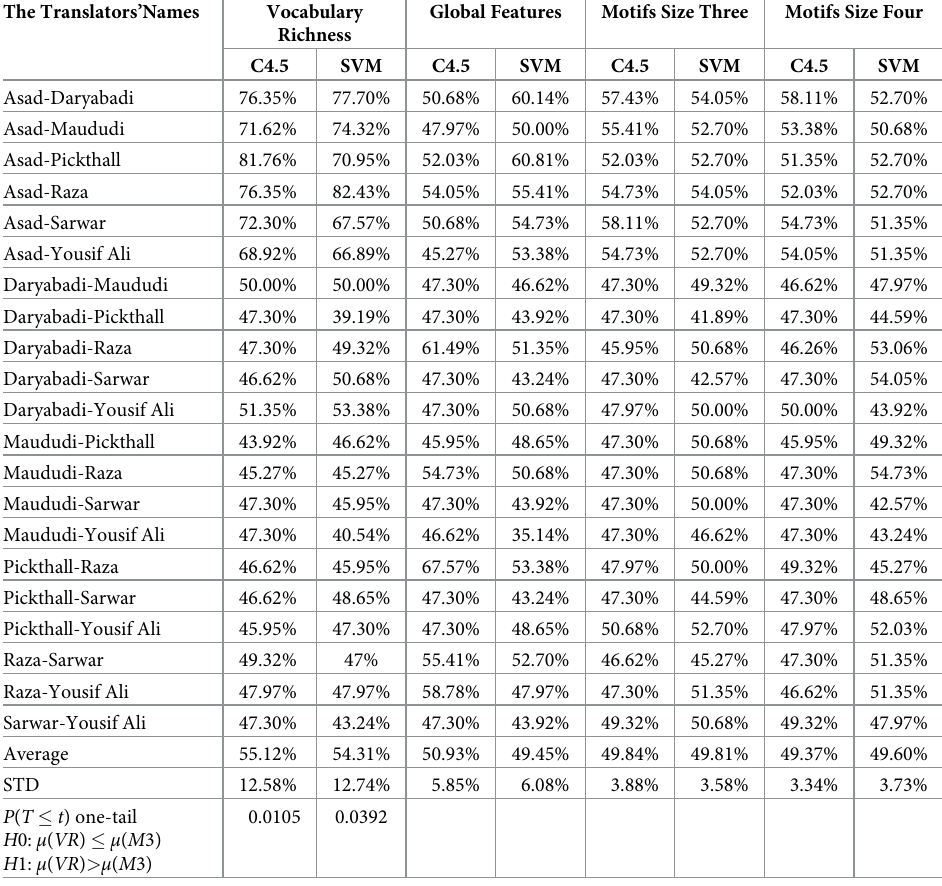
Table 9. Classification results for vocabulary richness measures, network global features, motifs size three and motifs size four as translator stylometry features for the 1st corpus.